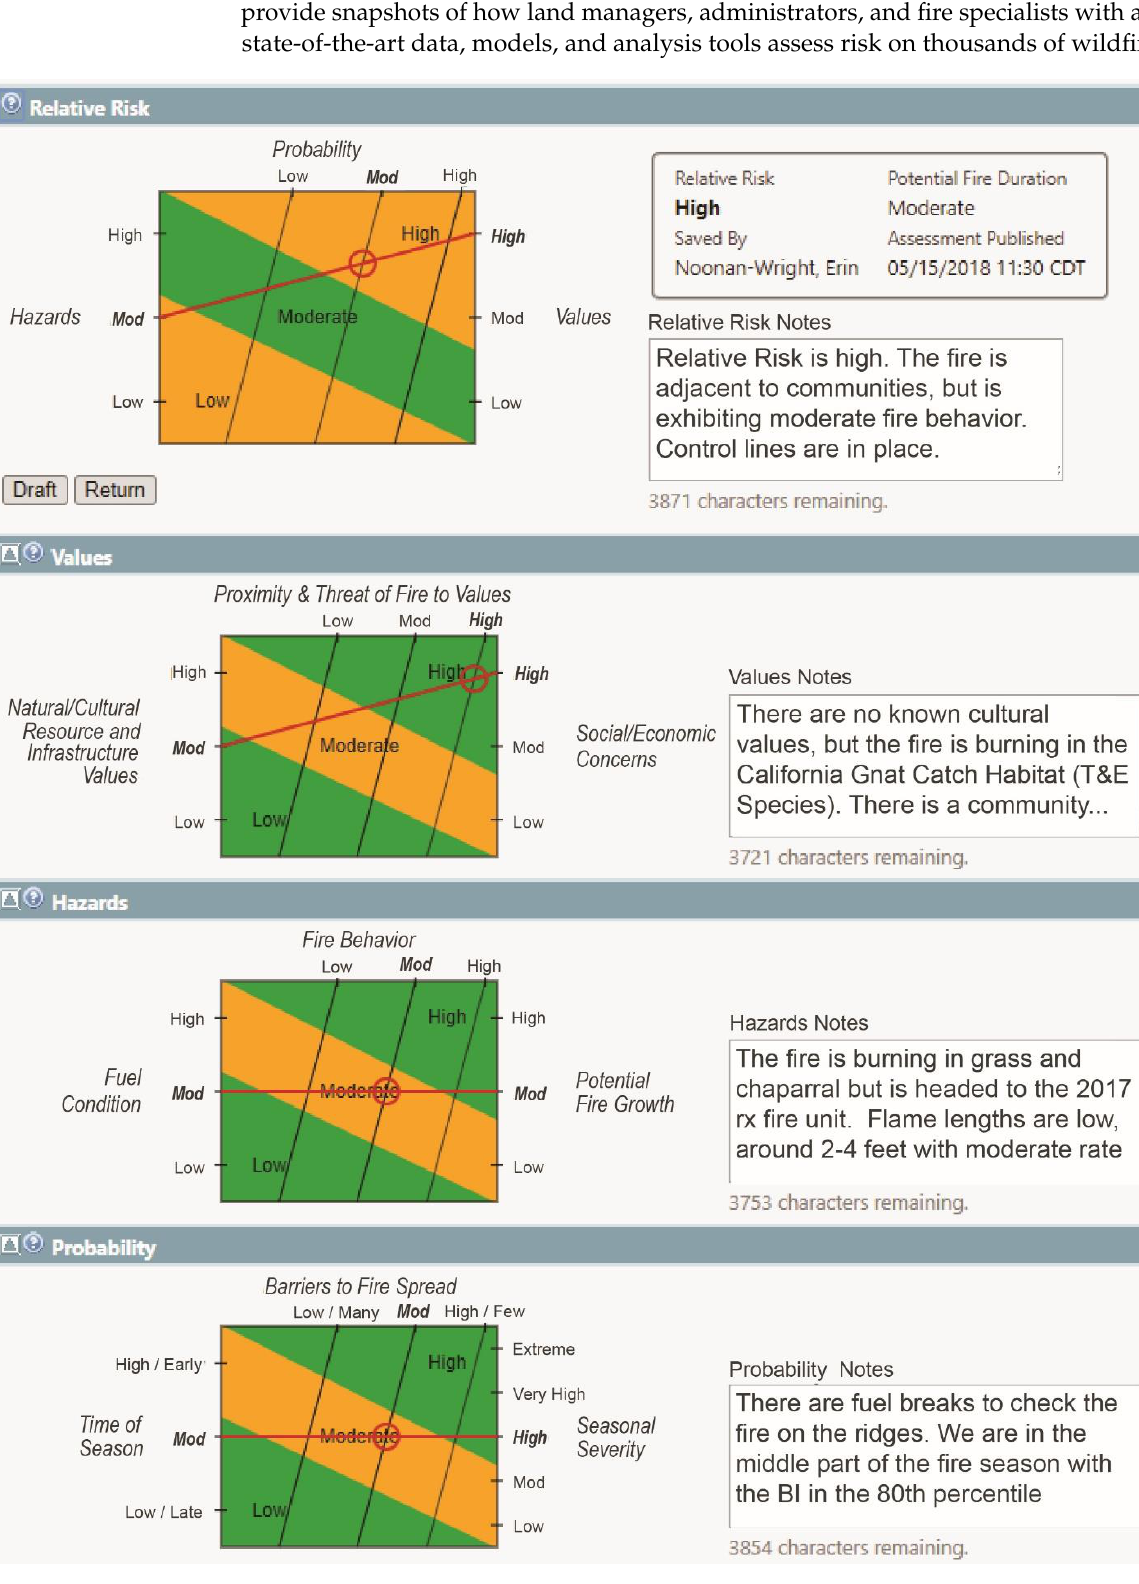
Figure 1. An example of the relative risk assessment in the U.S. Wildland Fire Decision Support System (WFDSS) and qualitative text (summarized into the prescence/absence of codes and themes) to support semi-empirical ratings for relative risk, values, hazards and probability.